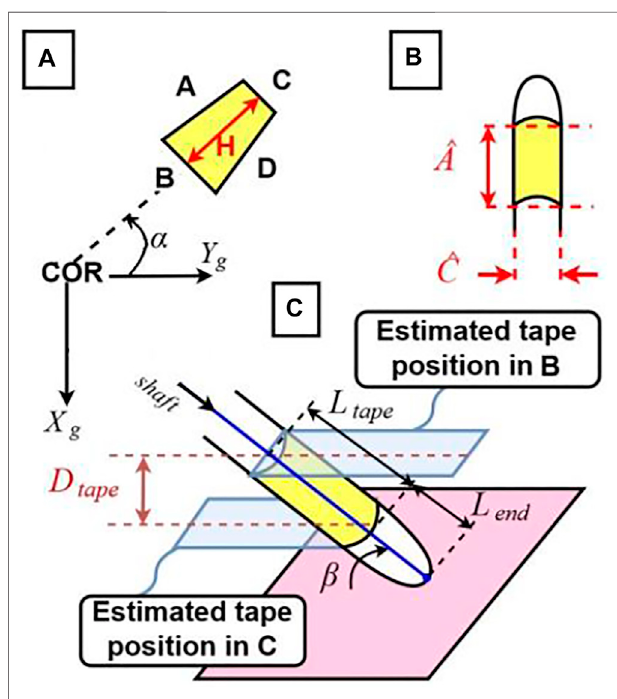
FIGURE 6 | (A) Estimated α angle, rotation around Z of the instrument aroundtheCenterofRotationandparametersofthetrapezoidaldetection; (B) parameters of the real instruments; (C) estimated β angle, rotation around X.